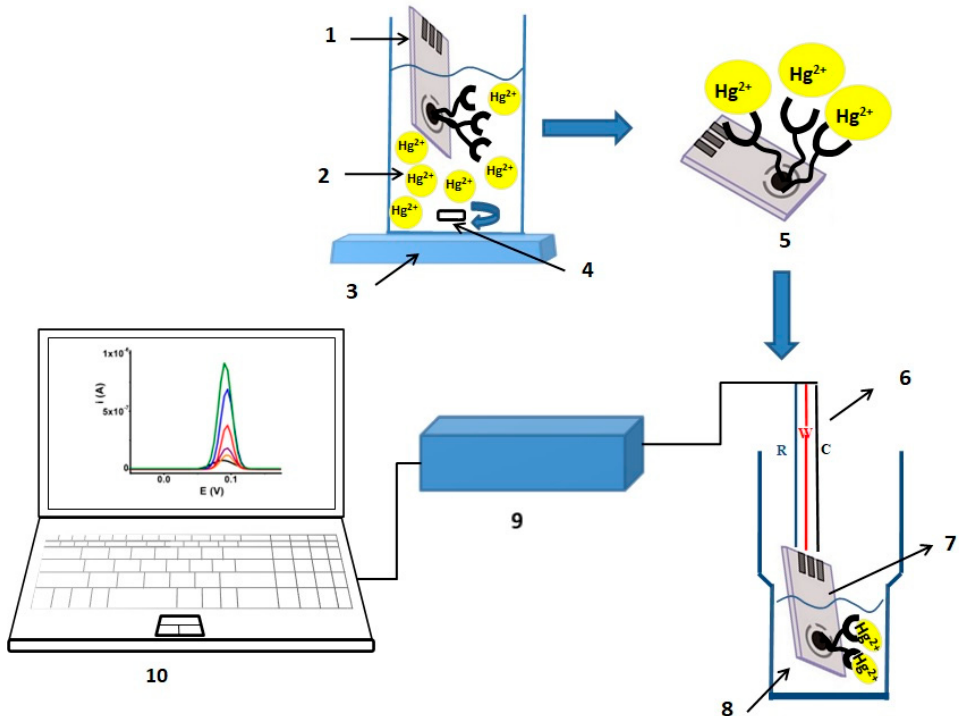
Figure 2. Principle scheme for the realization of the electrochemical process for the determination of Hg 2+ ions in wastewater: 1—electrode with deposited polymer; 2—electrochemical cell with 20 mL 0.05 M acetate buffer solution at pH = 3; 3—magnetic stirrer; 4—Teflon magnet; 5—electrode with complexed Hg 2+ ions and uncomplexed Hg 2+ ions; 6—three electrical contacts; 7—electrode with complexed Hg 2+ ions; 8—electrochemical cell; 9—portable potentiostat; 10—laptop with in- stalled software.